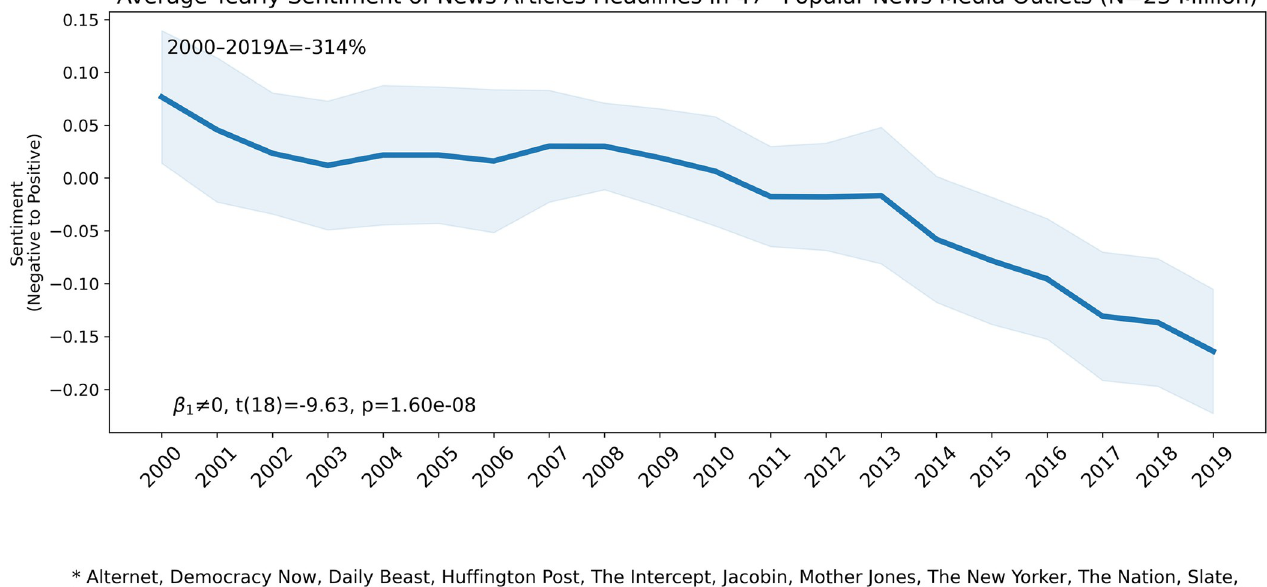
Fig 1. The solid blue line shows the average yearly sentiment of headlines across 47 popular news media outlets. The shaded area indicates the 95% confidence interval around the mean. A statistical test for the null hypothesis of zero slope is shown on the bottom left of the plot. The percentage change on average yearly sentiment across outlets between 2000 and 2019 is shown on the top left of the